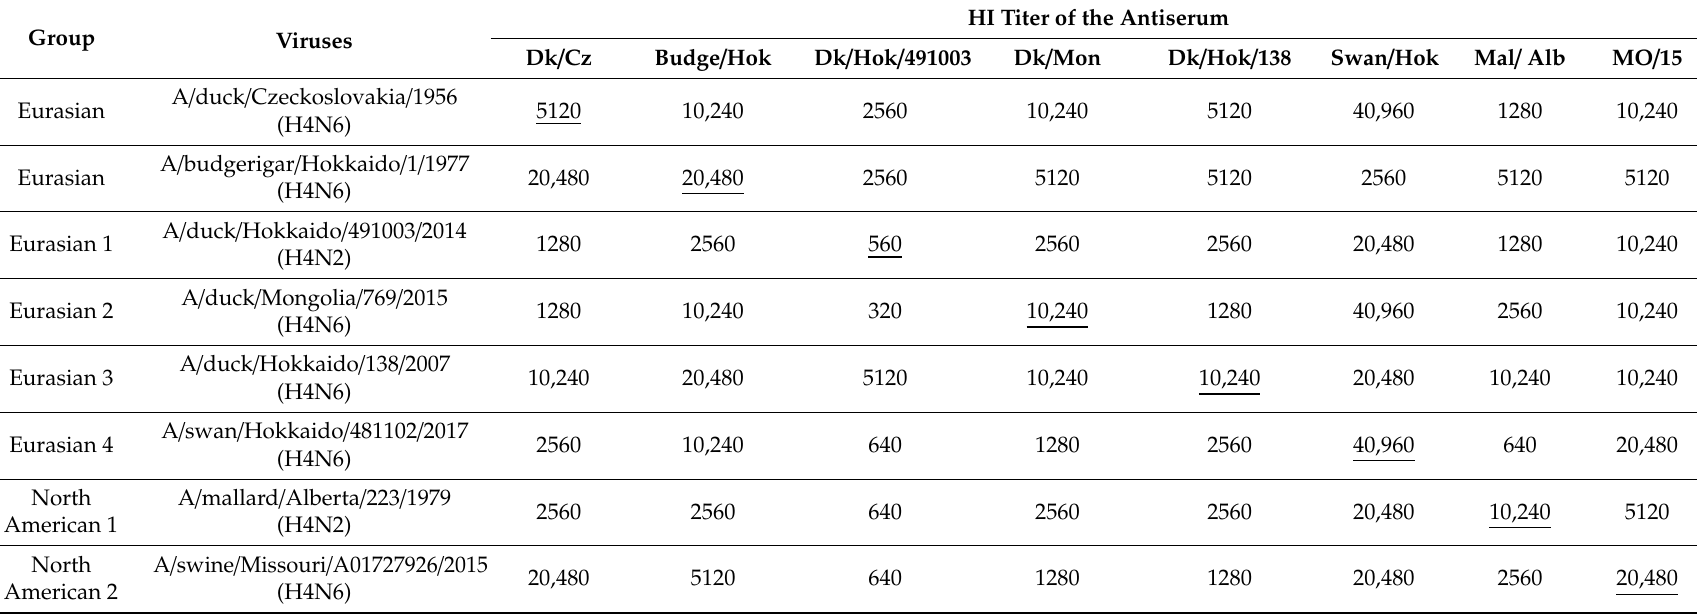
Homologous titers are